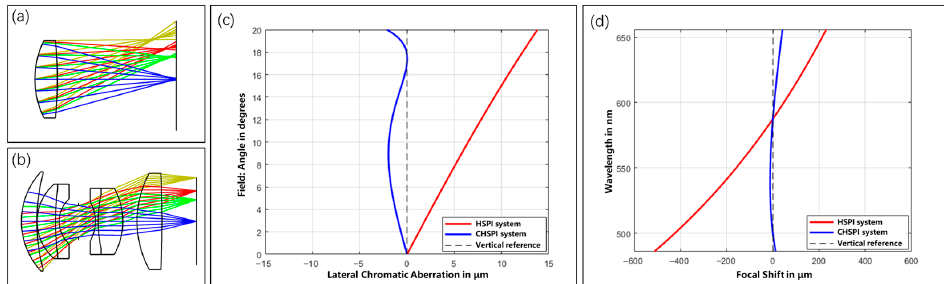
Figure 4. Simulation results of a single-lens system and TV lens system. Layout of imaging parts in